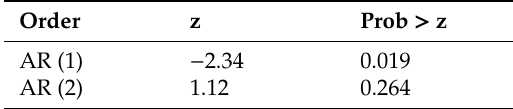
Table 5. Arellano-Bond (AR) (1) and AR (2)